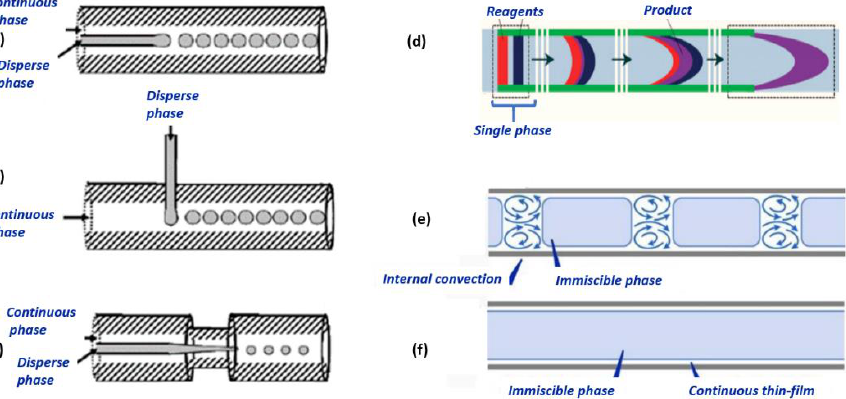
Figure 3. Common microfluidic flow types: ( a ) co-flow [96], ( b ) cross-flow [96], ( c ) flow-focusing [96], ( d ) continuous flow [97], ( e ) slug flow [98], and ( f ) annular flow [98]. Reprinted from open- access sources.